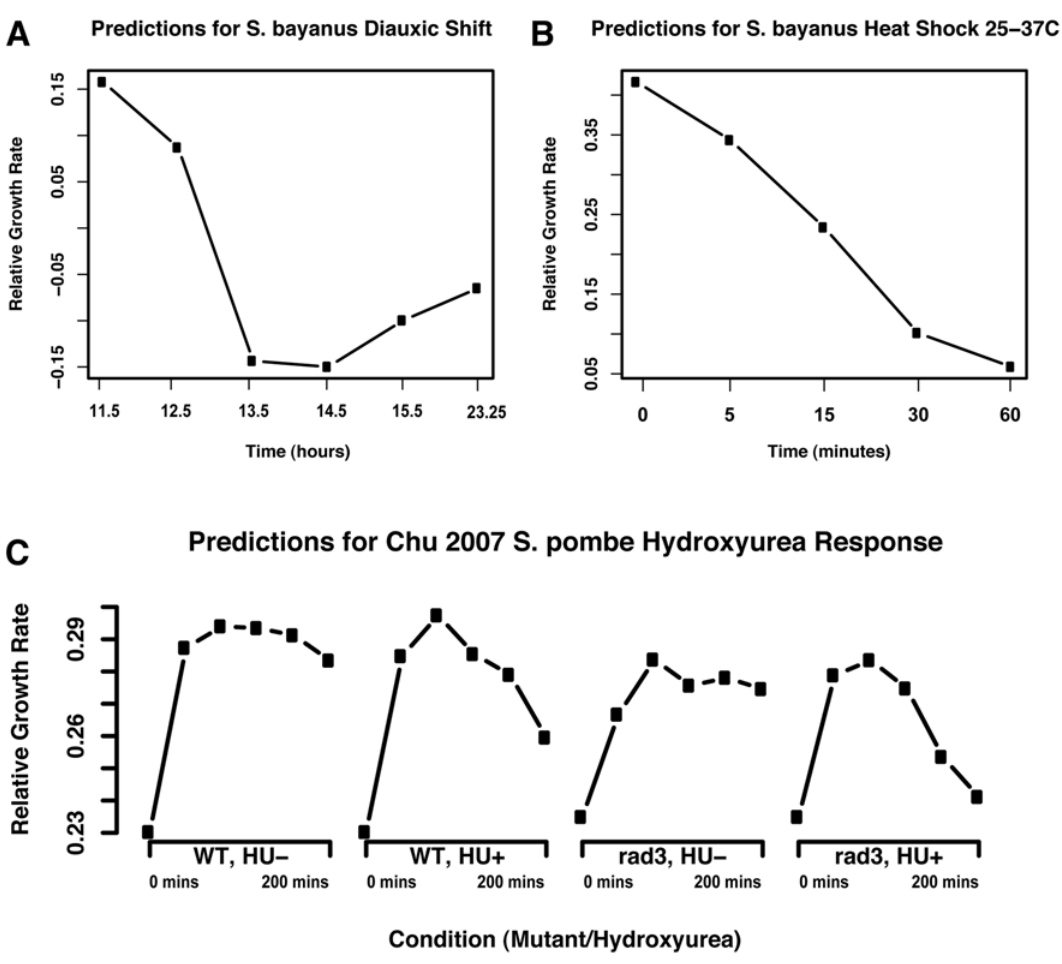
Figure 6. Predicted growth rates for S.bayanus and S.pombe expression datasets. By examining genes orthologous to our , 70 S. cerevisiae growth-specific calibration genes, we successfully applied our model to predict growth rates in S. bayanus ( , 50 orthologous growth-specific genes, , 20 M years diverged) and S. pombe ( , 75 growth-specific genes due to one-to-many mappings, , 1B years diverged). (A) Predicted growth rates for S. bayanus undergoing the diauxic shift from fermentative to respiratory growth (Table S3). As observed for the S. cerevisiae diauxic shift in [4], growth pauses as glucose is exhausted and resumes as the yeast begins consuming ethanol. (B) Predicted growth rates for S. bayanus exposed to a 25–37 C heat shock (Table S3). In contrast to Figure 4B, in which S. cerevisiae is observed to recover from a 37 C heat shock, the less-thermotolerant S. bayanus [28] is predicted to halt growth at high temperatures. (C) Predicted growth rates for S. pombe wild-type and rad3 D time courses, grown normally and exposed to hydroxyurea (HU, an inhibitor of DNA synthesis and thus growth) [29]. Despite the wide evolutionary divergence between S. pombe and our S. cerevisiae training data, predicted growth rates are in substantial agreement with expected biology. Each time course begins with low growth in a synchronized culture. When the synchronization block is released, cells begin growing, wild-type more efficiently than the rad3 D mutant. Exposure to HU decreases growth over time, and this effect is exacerbated by RAD3 deletion. While the S. cerevisiae RAD3 ortholog MEC1 is essential, knockouts of the MEC1 pathway members SOD1 and LYS7 have been previously observed to induce HU sensitivity